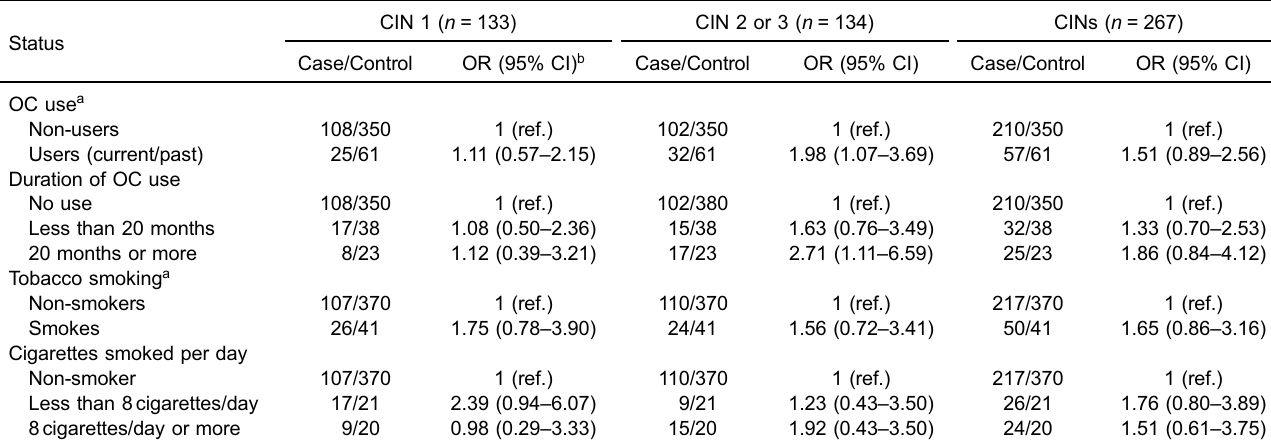
Table 2. Odds ratios of oral contraceptive use and smoking for cervical intraepithelial neoplasia risk